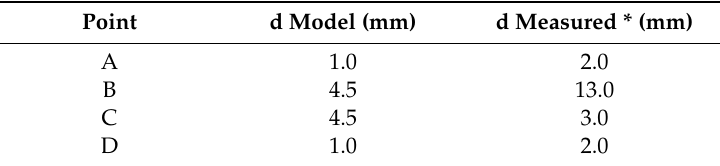
Table 3. Comparison between model and measured displacements at the final stage of the fire test (60